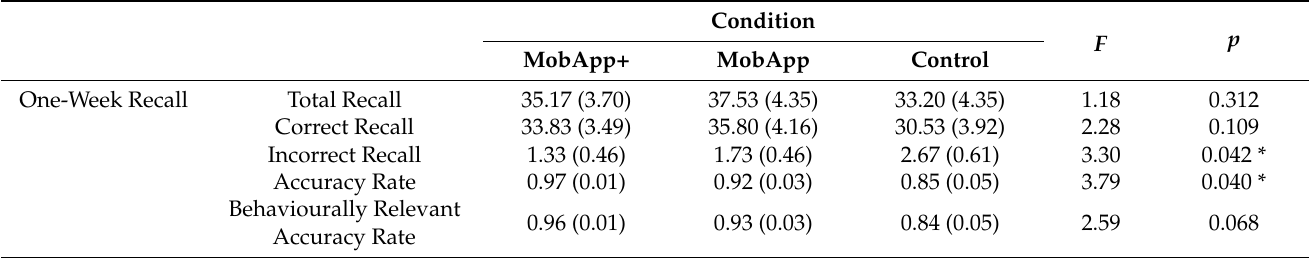
Table 2. Descriptive and Inferential Statistics for One-Way